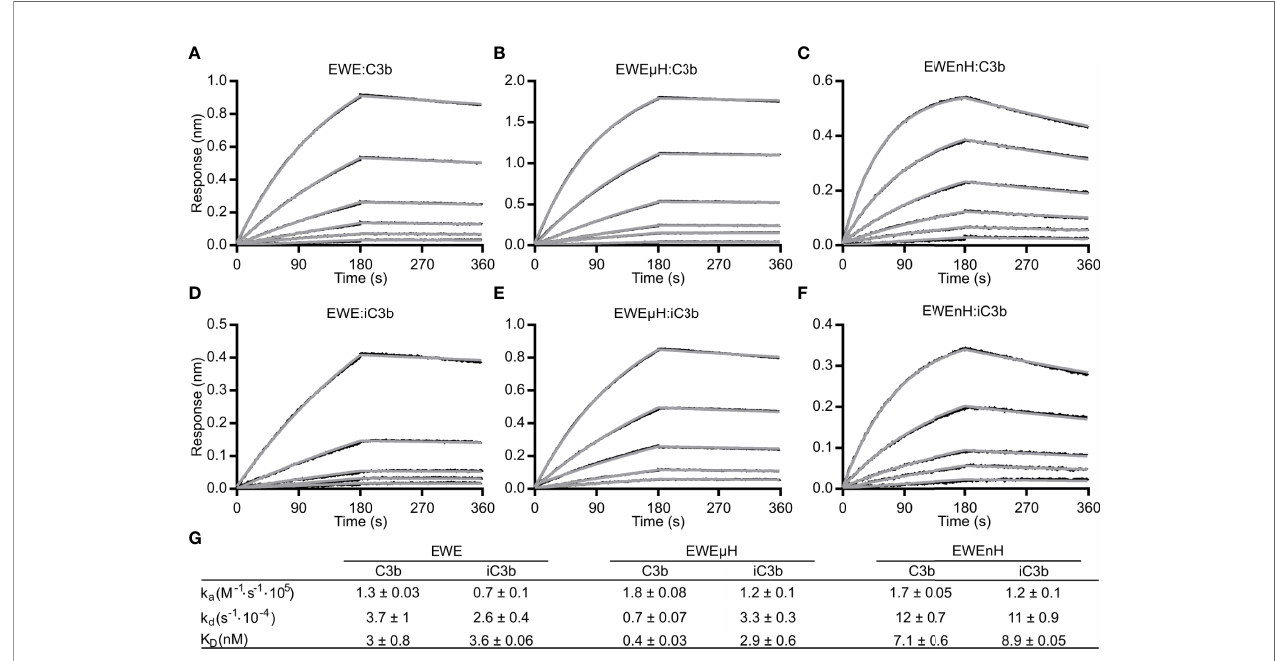
FIGURE 4 | Bio-layer interferometry-based analyses of EWE fusion proteins. (A) EWE, (B) EWEµH or (C) EWEnH was immobilized on a biosensor via the C-terminal 6xHis-tag and transferred into dilution series of (A, B) 1.5625-50 nM C3b, and (C) 3.125-100 nM C3b. Similarly, (D) EWE, (E) EWEµH or (F) EWEnH was immobilized on biosensors and transferred into dilution series of (D, E) 3.125-50 nM iC3b or (F) 6.25-100 nM iC3b. (G) The table summarizes the rate constants of association and dissociation from n=3 experiments for C3b kinetics and n=2 experiments for iC3b kinetics. nm ,